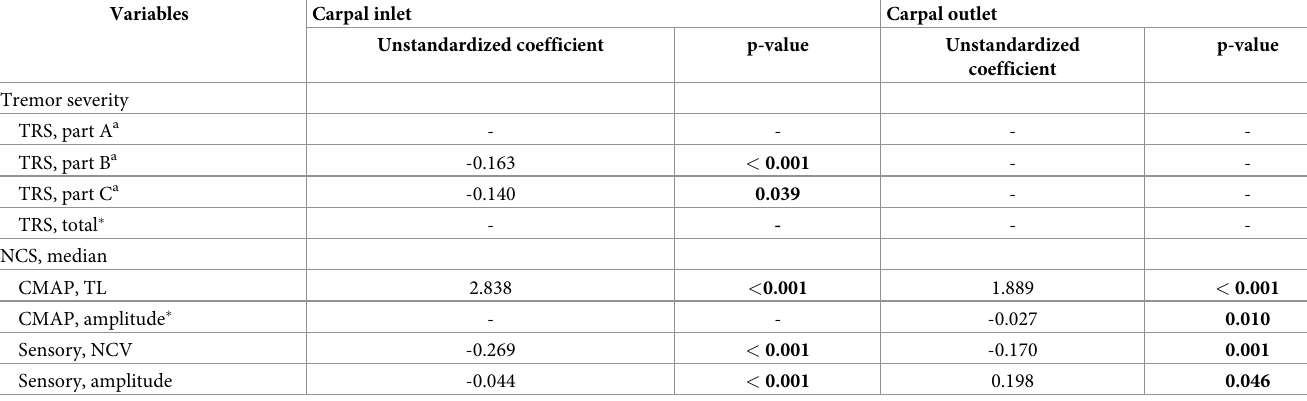
Table 3. Correlation between mCSA at the wrist level and other variables in patients with